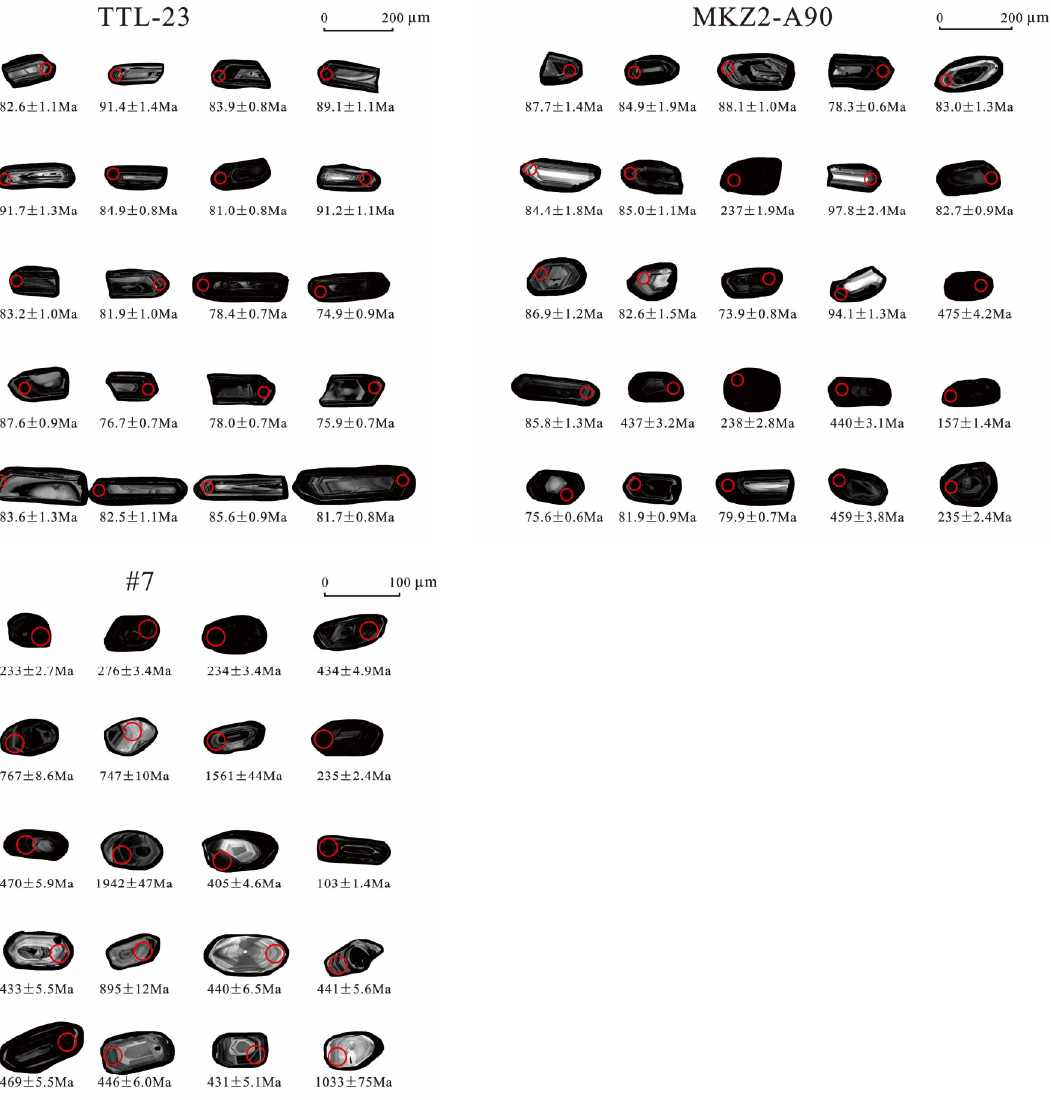
Figure A3. Zircon CL images. The red circle in all figures indicate the spot position of Zircon U-Pb dating.